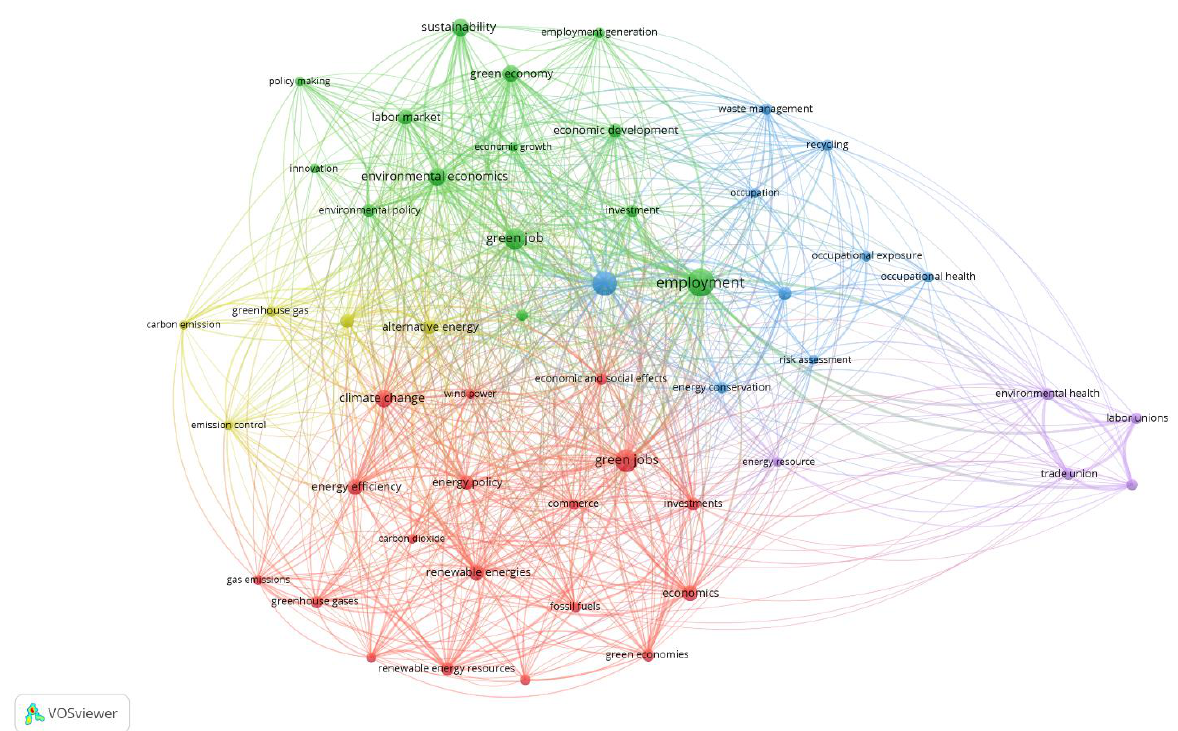
Figure 4. Bibliometric map of keywords co-occurrences Q5 results analysis in Scopus. Source: Authors ’ elaboration.